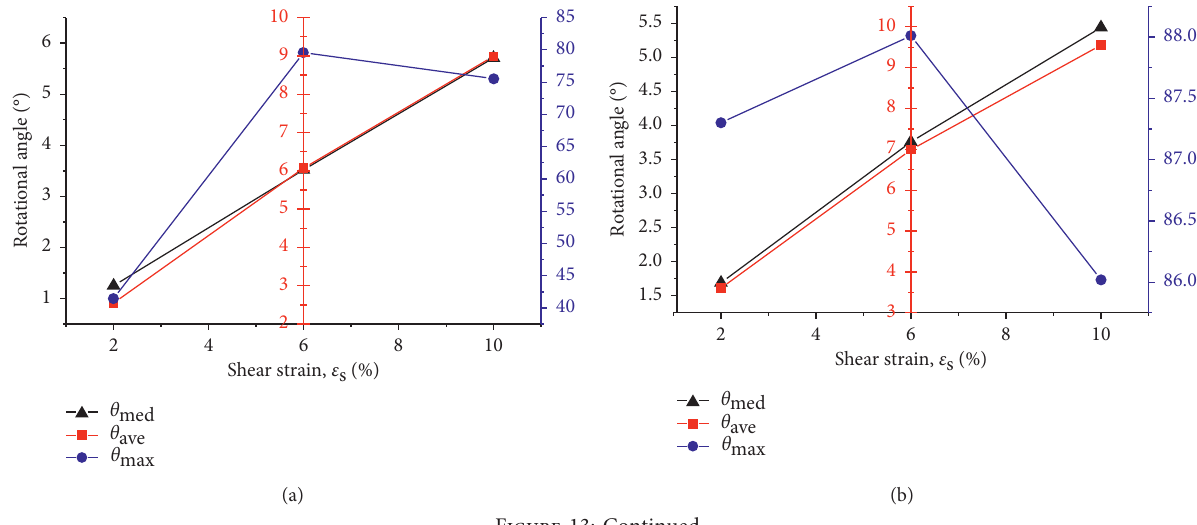
Figure 12: The maximum, medium, and average values of particle rotation about the negative y -axis: (a) σ (c) σ n � 55 kPa; (d) σ n � 75 kPa.